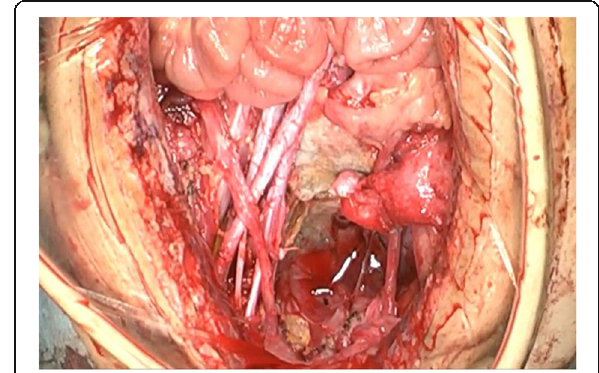
Fig. 3 Intraoperative finding: The patient received the whole mass resection, ileocecal resection with lymph node dissection, and subsequent sigmoidectomy and